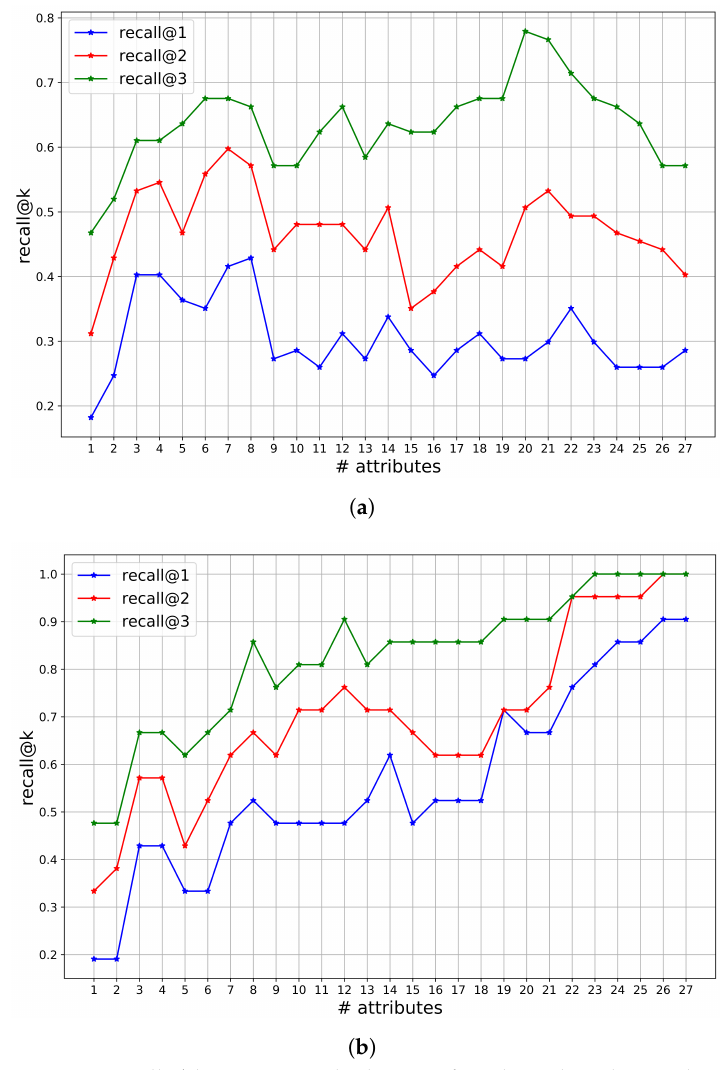
Figure 3. Recall@ k by incremental selection of attributes based on ranking of Table 4 for MUS ( a ) and SES ( b